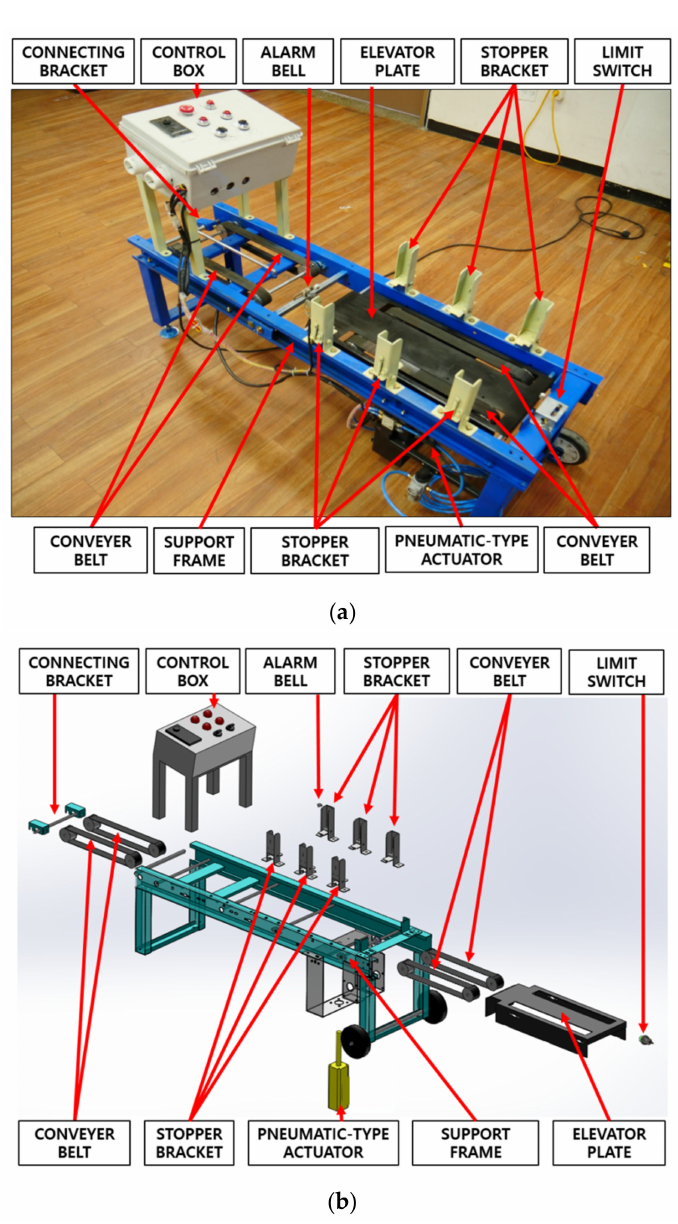
Figure 14. Shape of the automatic accumulating equipment: ( a ) picture and ( b ) 3D